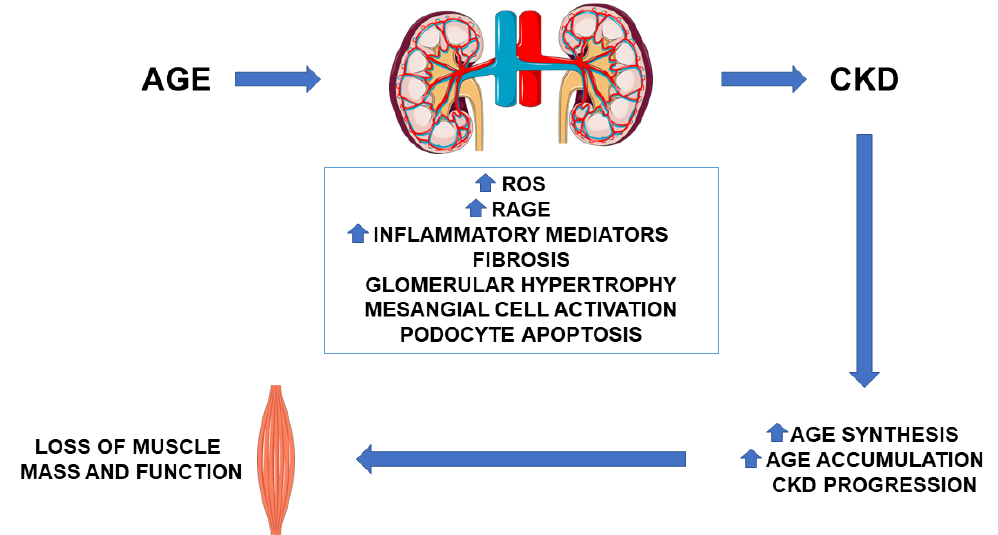
Figure 2. Advanced glycation end products (AGE) in chronic kidney disease (CKD). AGE contributes to CKD progression by increasing reactive oxygen species (ROS) generation, up-regulating the expression of the receptor for advanced glycation end products (RAGE), and inducing inflammation and fibrosis, all mechanisms affecting glomerular function. Indeed, this activates a vicious circle that increases AGE and uremic toxin accumulation and oxidative stress and promotes loss of muscle mass and function.